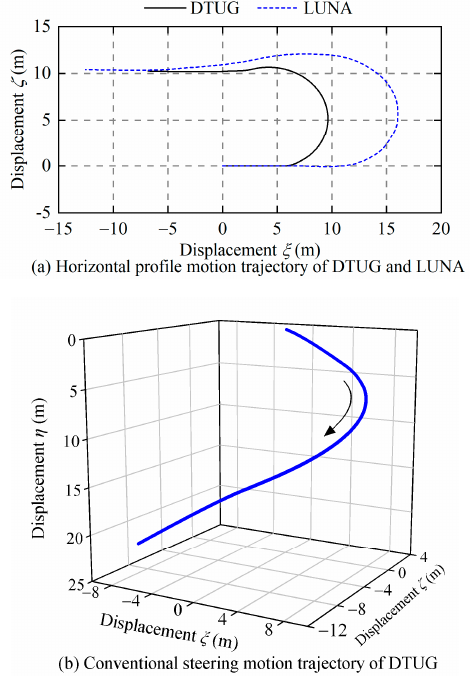
Figure 6. The trajectory of the conventional steering motion of the DTUG.